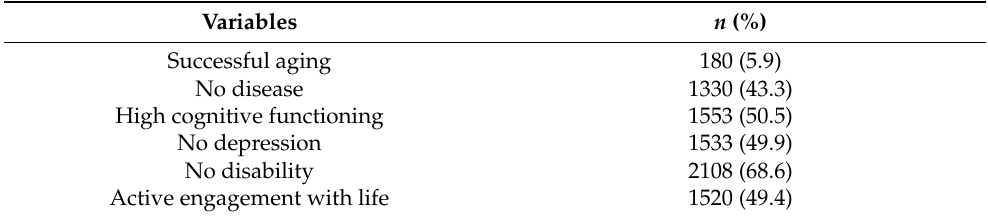
Table 2. Percentage of participants meeting the criteria of successful aging.